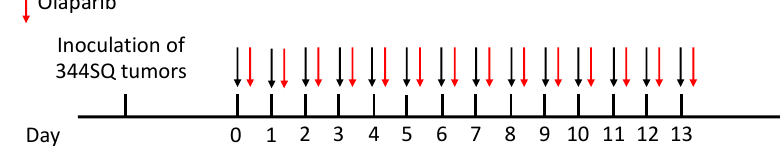
Figure 5. Tumor kinetics and survival after aurola combination therapy in syngeneic lung adenocarcinoma mouse model. Male 129S2/SvPasCrl (129-) mice were injected with 1 × 10 6 344SQ cells subcutaneously. When tumors reached a size of 40–50 mm 3 (day 0), mice were randomized and treated with vehicle, AF (15 mg/kg), olaparib (200 mg/kg), or aurola (15 mg/kg AF + 200 mg/kg olaparib). ( A ) Treatment scheme showing timing of AF treatment (15 mg/kg via oral gavage administered for 14 consecutive days) with black arrows and olaparib treatment (200 mg/kg via oral 0